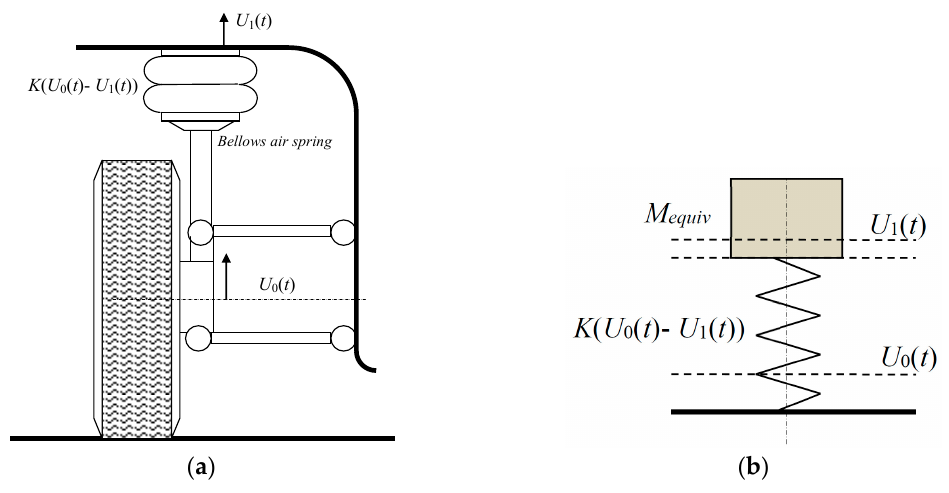
Figure 6. Sketch of a vehicle suspension and the equivalent dynamic model for a case of passive transmission: ( a ) drawing; and ( b ) symbology